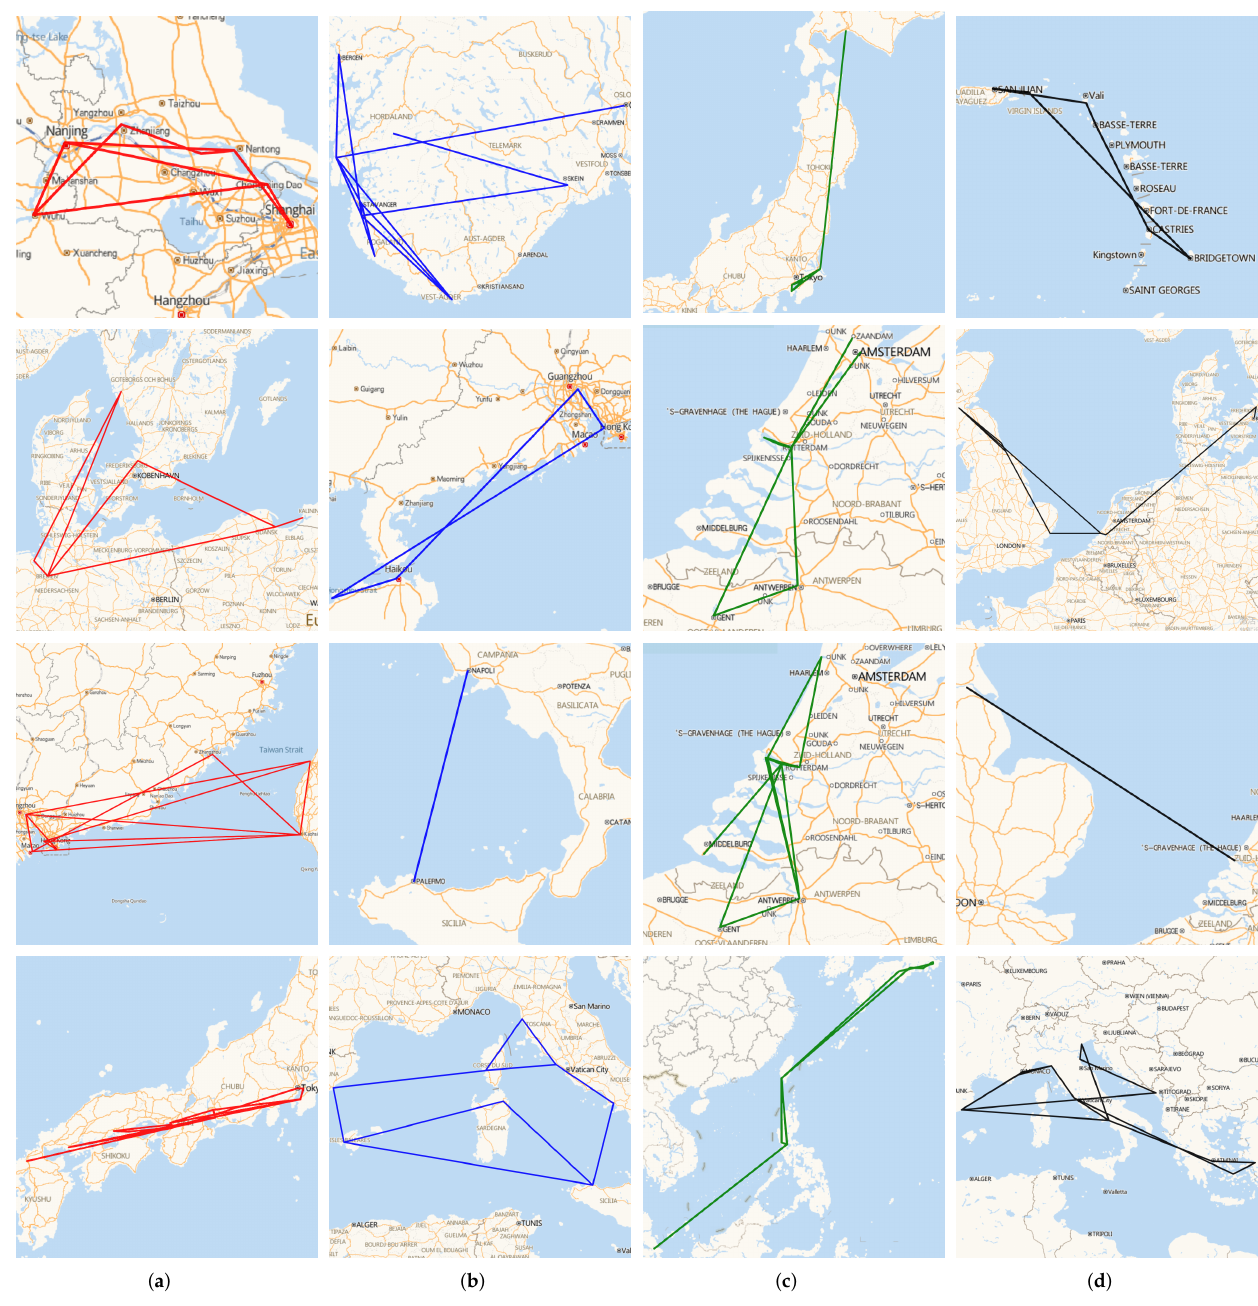
Figure 9. Ship moored records examples. We show the moored records of four different types of ships. The moored records of four ships in a month are selected randomly from each type of ship for visualization. Each column in the map represents the moored records of ships of the same kind, and the colors of their moored records are also the same on the map. We can find that the same kind of ship’s moored records has no apparent similarity in both the geographical spatial distribution and the motion pattern. ( a ) Cargo; ( b ) Fishing; ( c ) Oil; ( d )